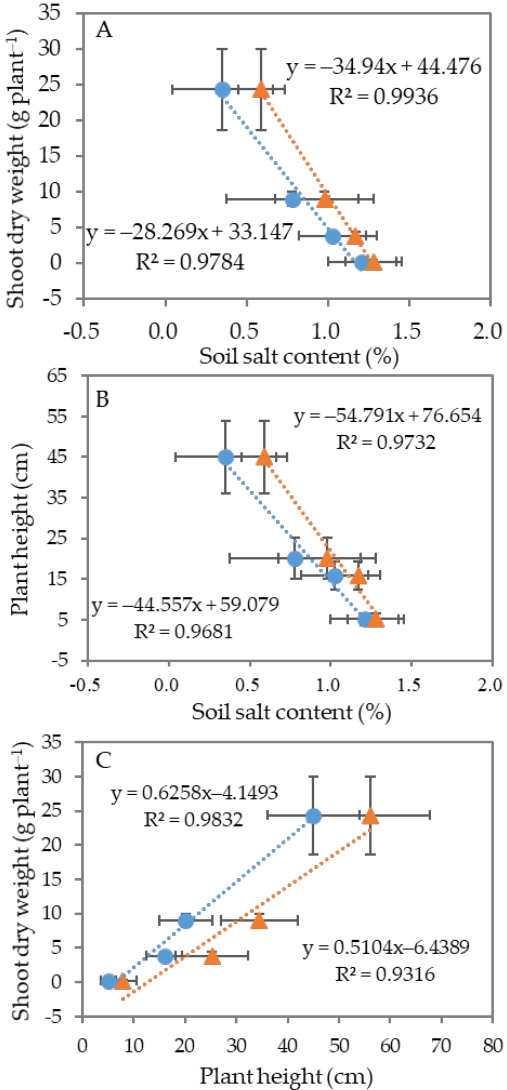
Figure 5. The relationships between soil salinity and shoot dry weight ( A ) and plant height ( B ), as well as between shoot dry weight and plant height ( C ). ( A , B ) A circle indicates the soil salt content sampled on 7 April, while a triangle indicates the soil salt content sampled on 26 June. ( C ) A circle indicates the plant height measured on 12 May, while a triangle indicates the plant height measured on 31 May. Data were represented as mean ± SD. Linear regression equations (y = ax + b) and the determination coefficient (R 2 ) are shown with the fitted trend lines.